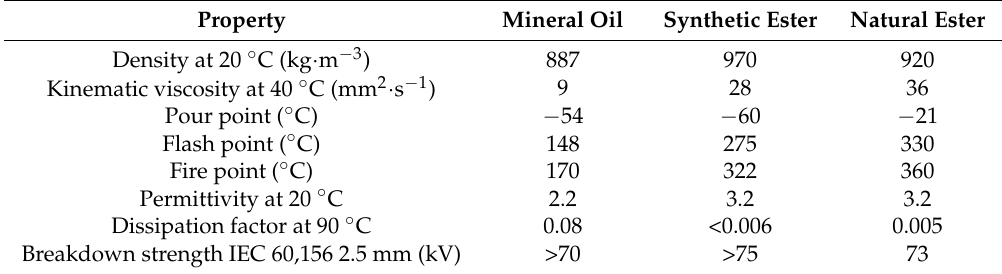
Table 1. Some physicochemical and dielectric properties of the electro-insulating liquids used